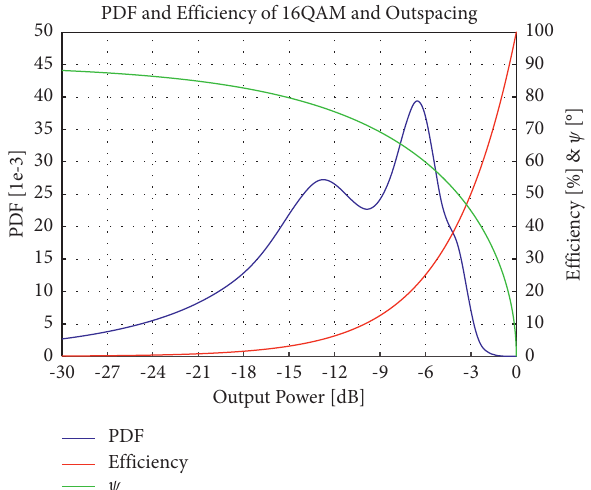
Figure 14: Probability density function of a QAM16 signal over output power, compared to the efficiency and outspacing angle ψ over output power for an isolated outspacing phased